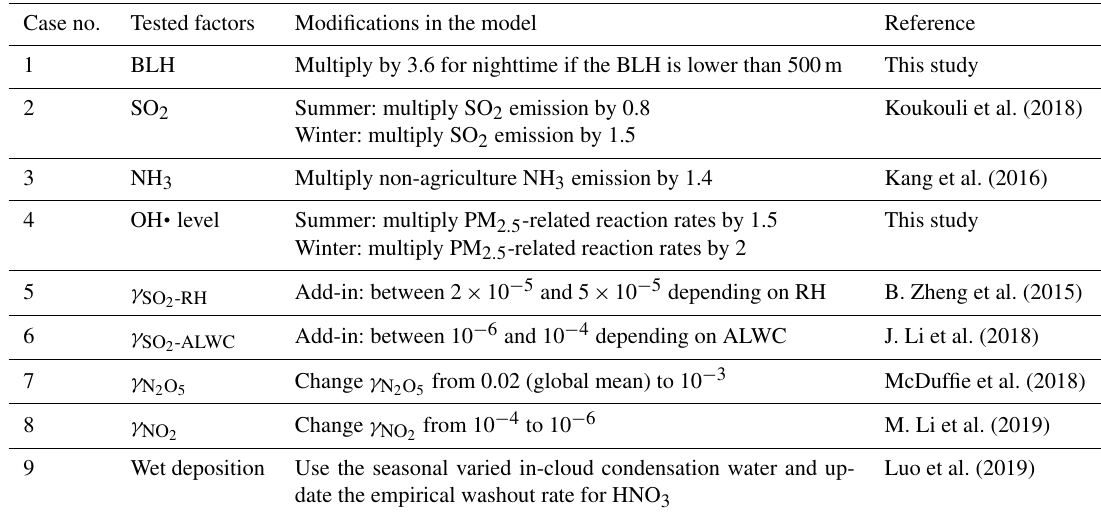
Table 2. Details of the sensitivity simulations from Cases 1 to